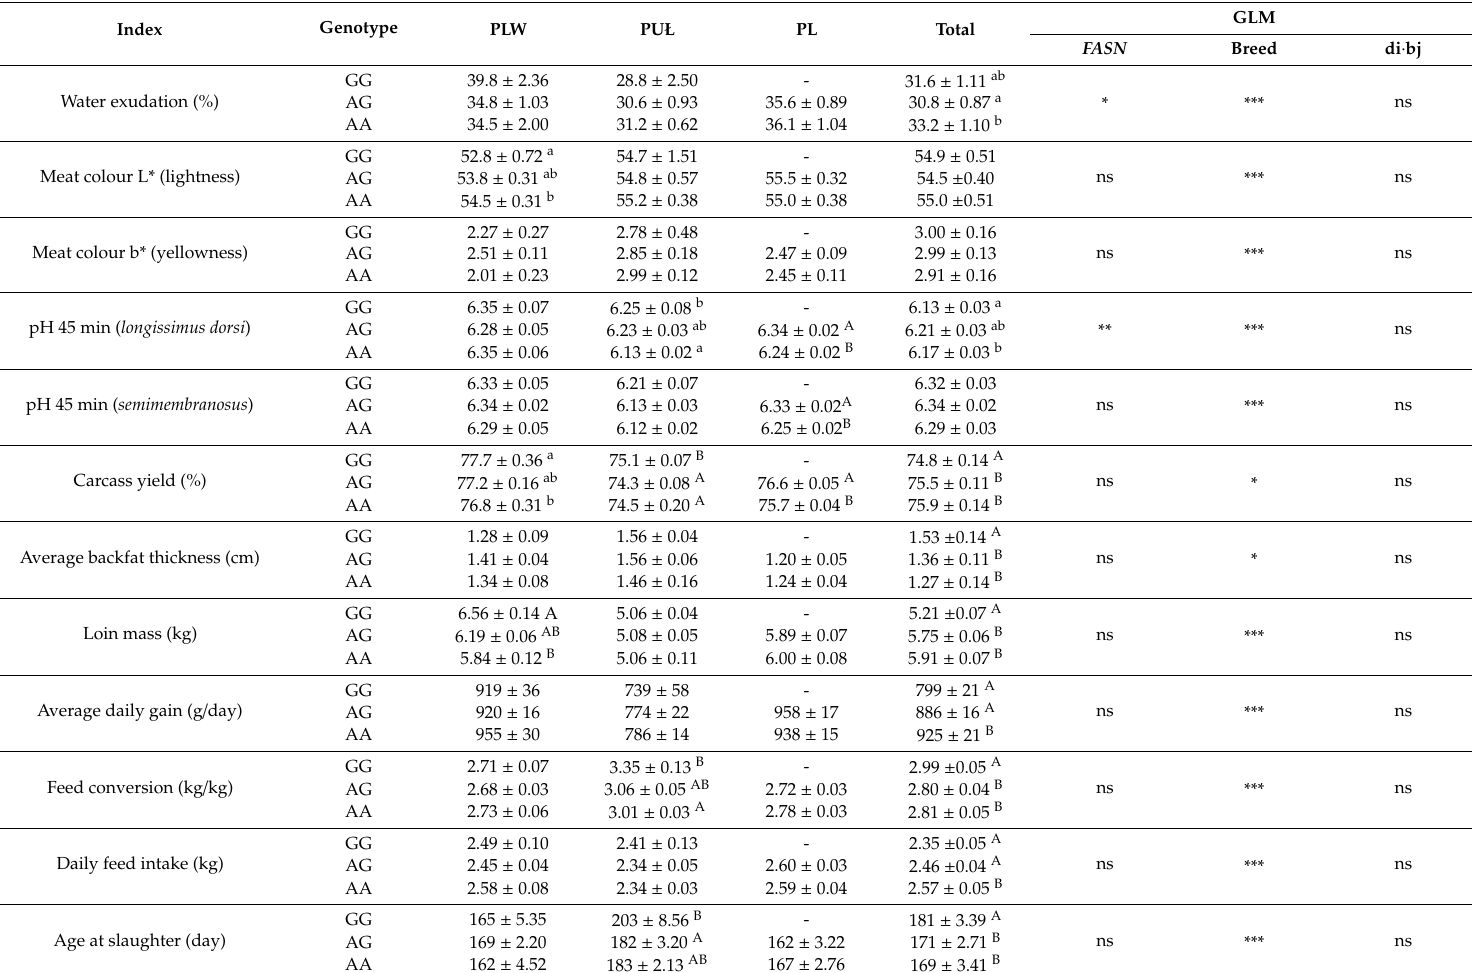
Table 2. Association of FASN gene and analysed traits (LSM ±